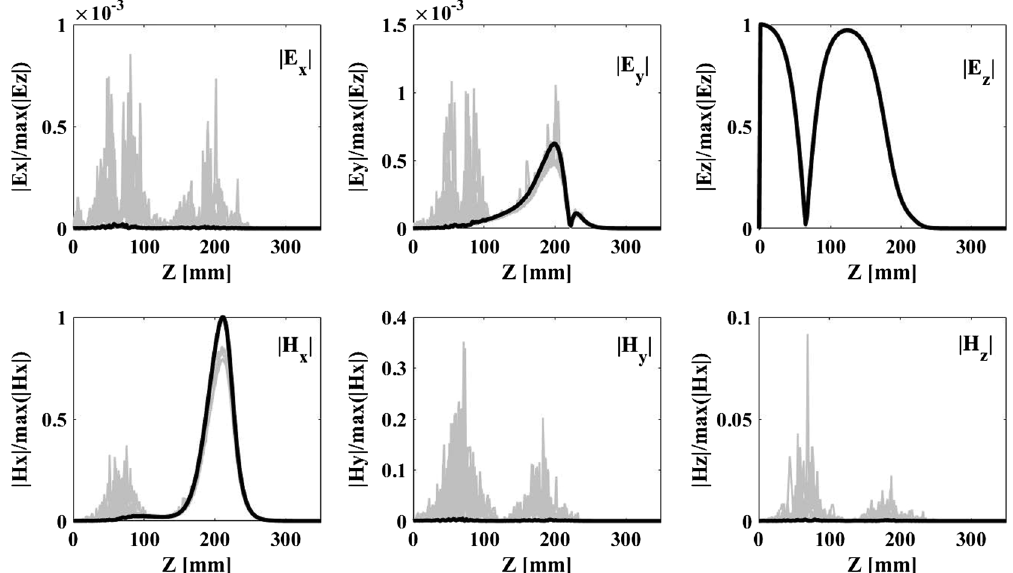
FIG. 3. Field components on the cavity axis. Black curves: converged results; Grey curves: history of intermediate results by refining mesh resolution of the simulation.